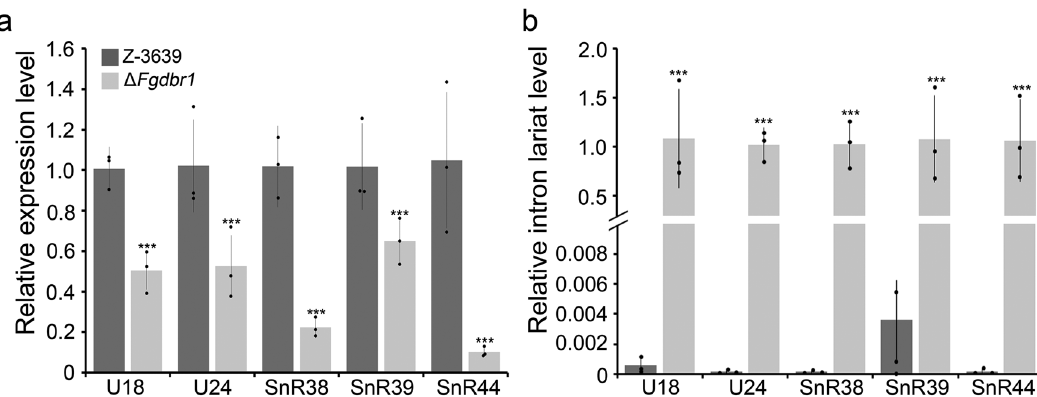
Fig. 6 Effect of FgDBR1 deletion on expression of snoRNA and intron lariat harboring snoRNA. a Relative expression level of intronic snoRNAs, U18, U24, SnR38, SnR39 and SnR44, in the wild-type and Δ Fgdbr1 strains was quanti fi ed by qRT-PCR. b Relative expression level of intron lariats that harbor snoRNAs. Intron lariat level was measured by qRT-PCR in RNase R-treated samples. Error bars represent standard deviations from three biological replicates. *** p <